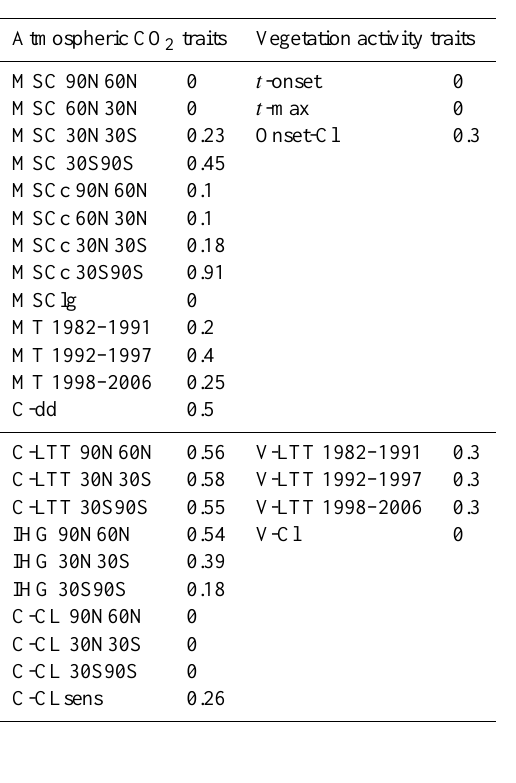
Table A1. Final scores of atmospheric CO 2 and vegetation activity for the baseline benchmark. Atmospheric CO 2 scores are reported per latitudinal band.